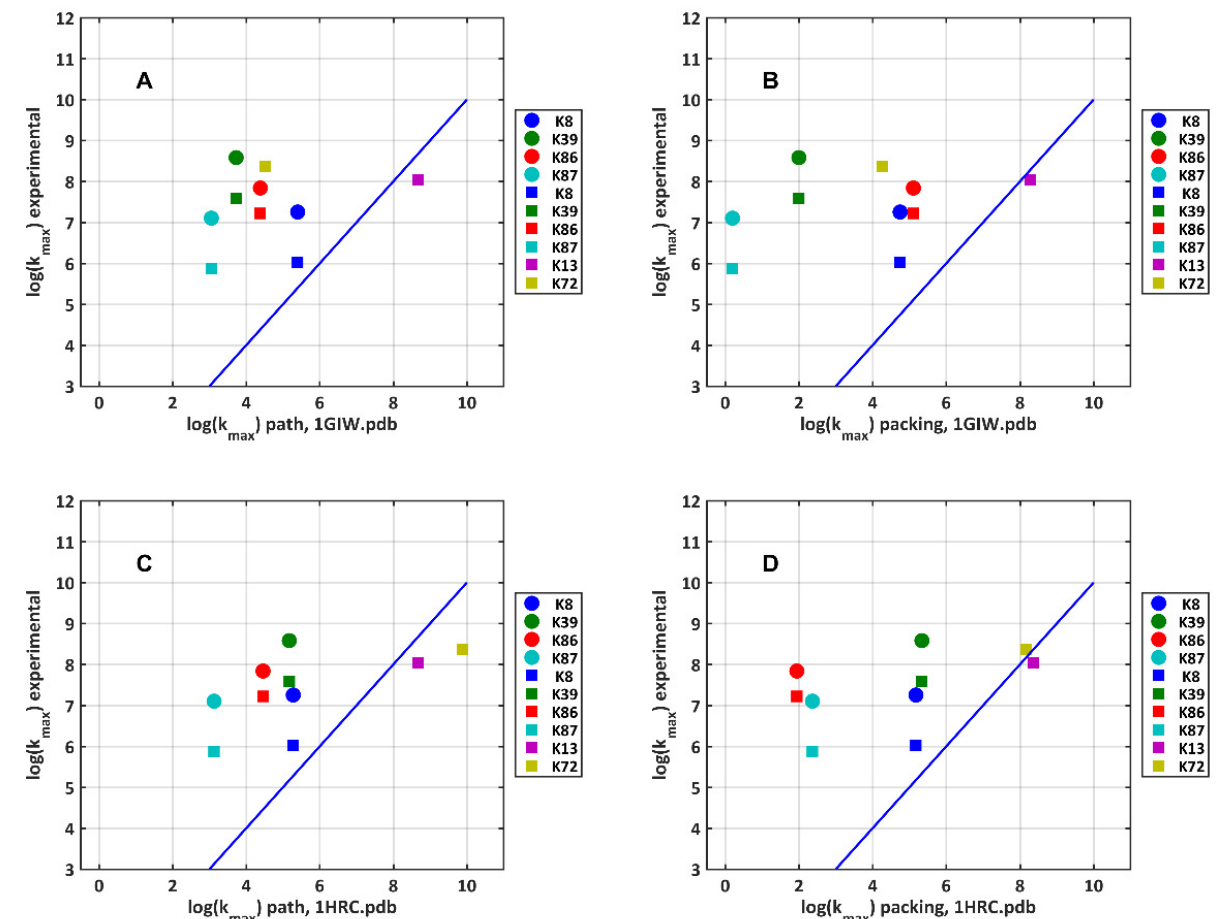
Figure 5. Comparison of the experimentally determined maximal electron transfer rates with the calculated maximal rates using two atomic resolution structural models of horse heart cytochrome c . Circles and squares represent forward and reverse electron transfer, respectively. Lines indicate equality between experimental and theoretical rates, to guide the eye: ( A ) Solution (NMR) structure used in the calculation with the pathway model; ( B ) solution structure, packing density model; ( C ) crystal (X-ray) structure used in the calculation, pathway model; ( D ) crystal structure, packing density model.